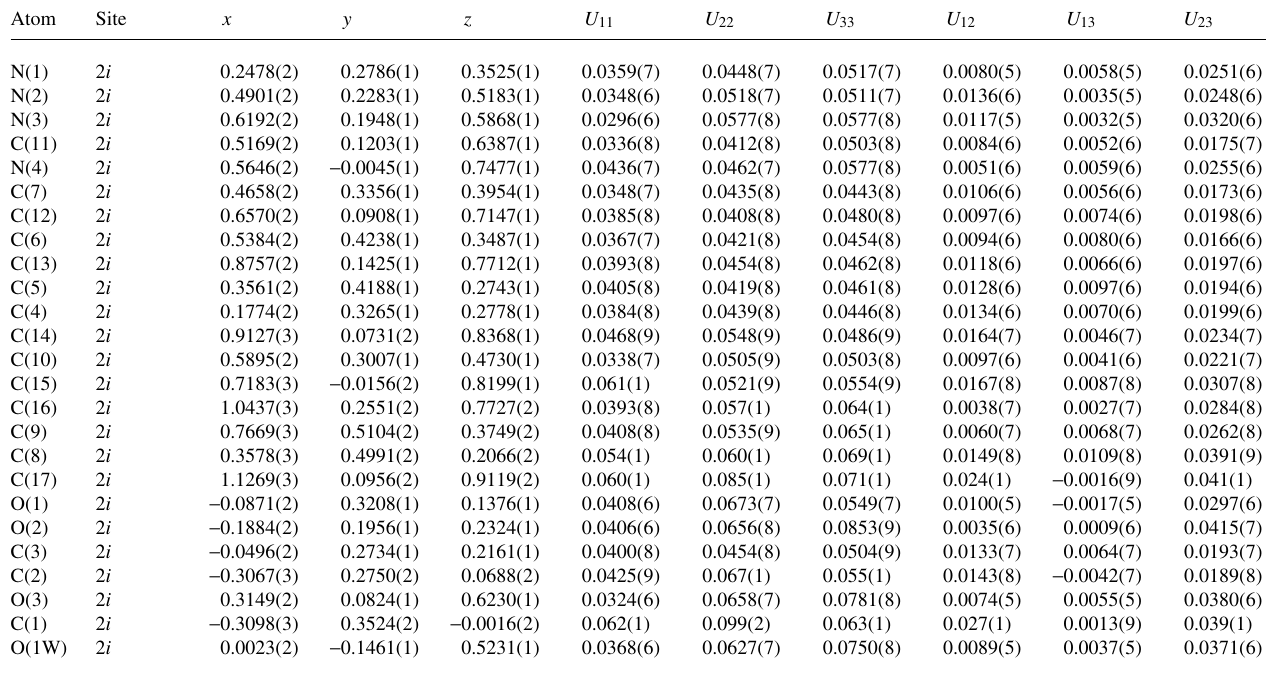
Table 3. Atomic coordinates and displacement parameters (in Å 2 )